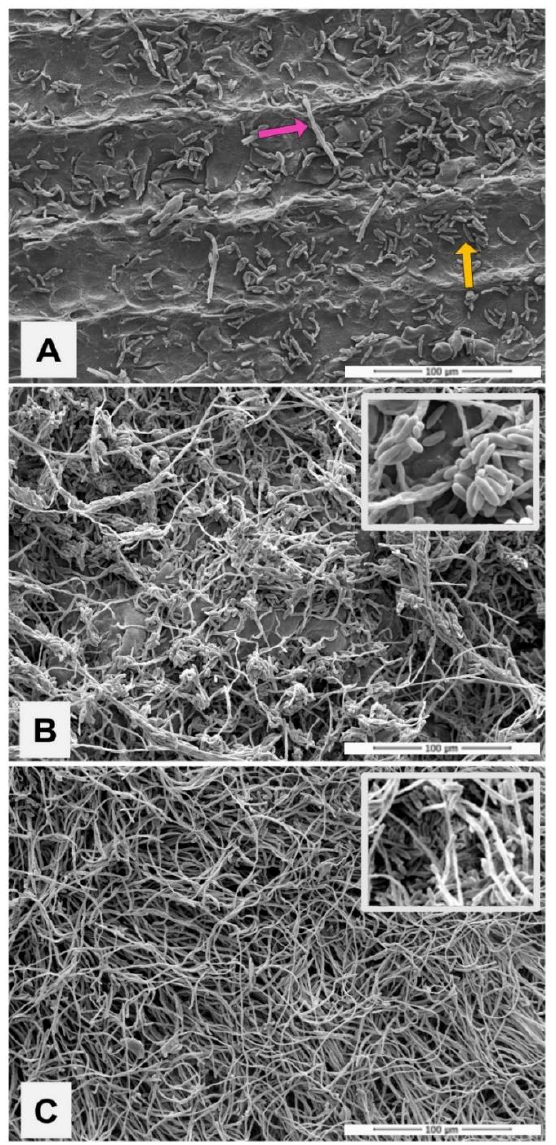
Figure 3. Scanning electron microscopy microphotographs showing the architecture of the biofilm produced by Neocosmospora keratoplastica using healthy and sterilized human nails as a unique nutritional source. ( A ) Within 24 h, a large number of conidia (yellow arrow) adhered to the entire surface of the nail, with the presence of developing hyphae (pink arrow); ( B ) after 96 h, the formation of hyphae is seen along the entire length of the nail and a large quantity of conidia in the shape of bunches (detail); ( C ) in 168 h, the biofilm can be seen already formed and organized, showing a dense tangle of hyphae and the presence of few conidia. SEM images at 1000× magnification. The formed biofilm in nails showed a significant increase in the number of colony- forming units (CFU) recovered from the biofilm at 96 h ( p < 0.0001) (Figure 4A). Mean- while, the metabolic activity decreased significantly ( p = 0.0013) (Figure 4B).